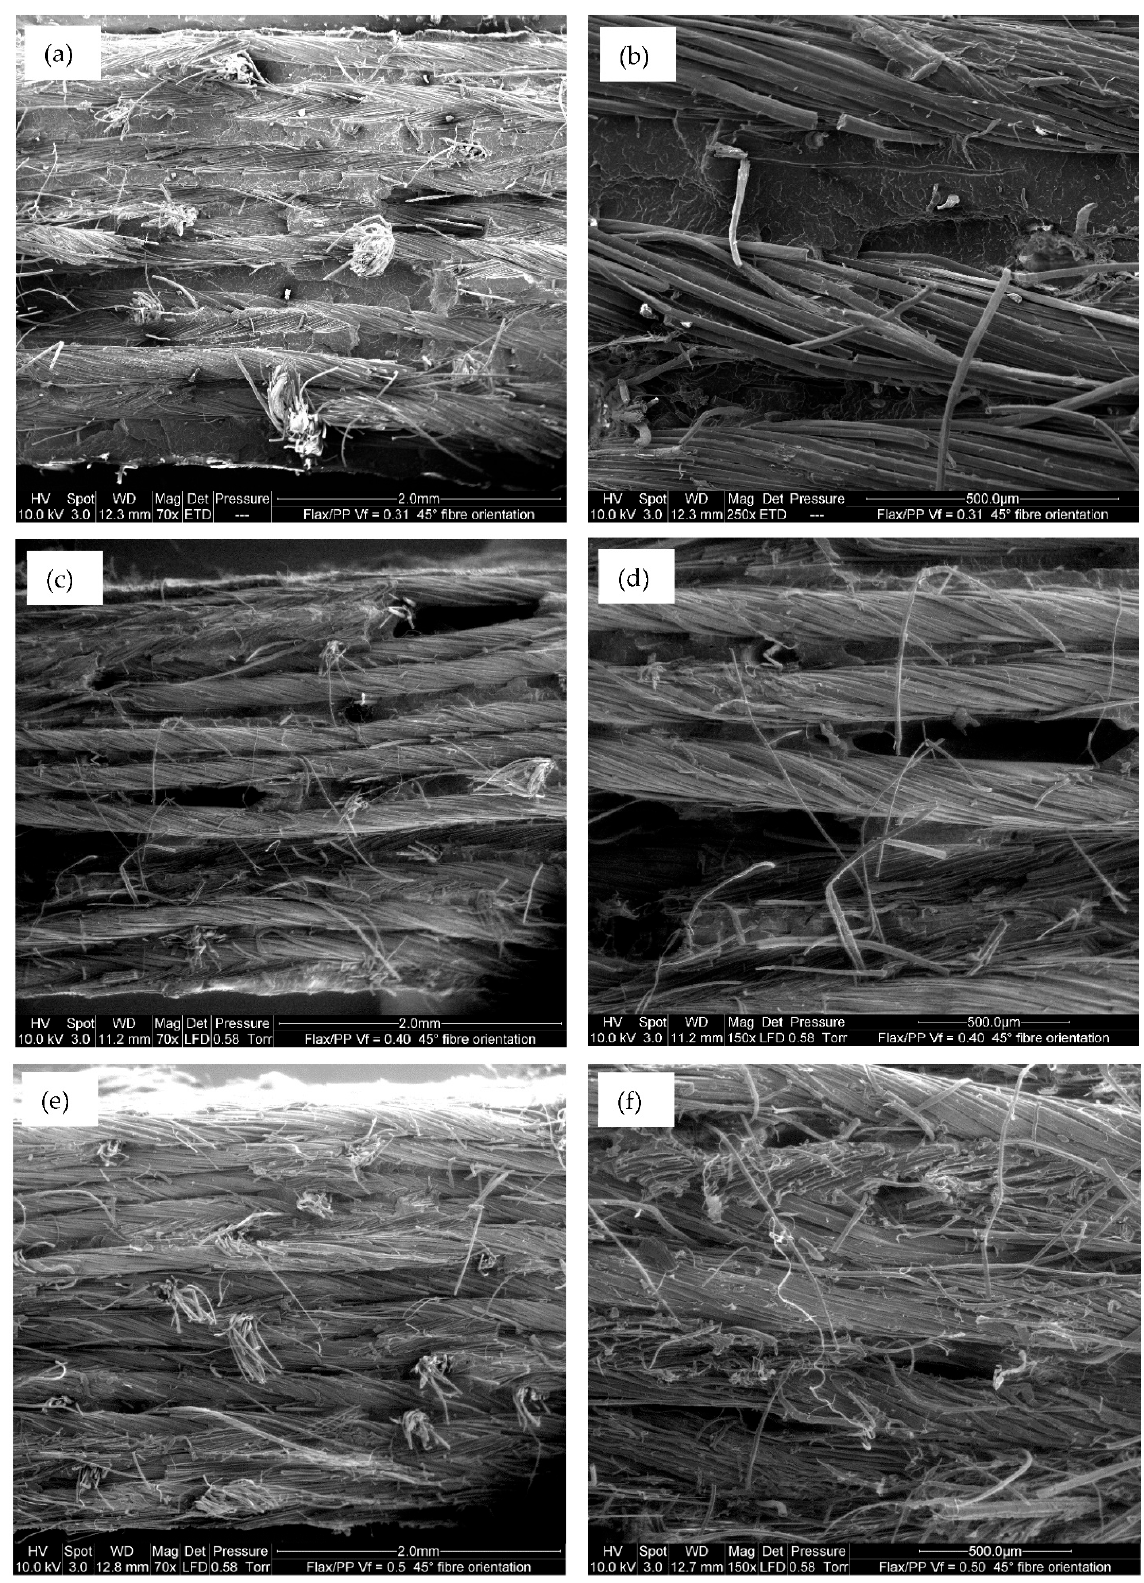
Figure 6. ESEM microimages of fracture samples: ( a , b ) showing no fibre-fibre contact ( V f = 0.31 and θ = 45 ◦ ), ( c , d ) showing insignificant fibre-fibre contact ( V f = 0.40 and θ = 45 ◦ ), and ( e , f ) showing significant fibre-fibre contact ( V f = 0.50 and θ = 45 ◦ ), respectively, at two different